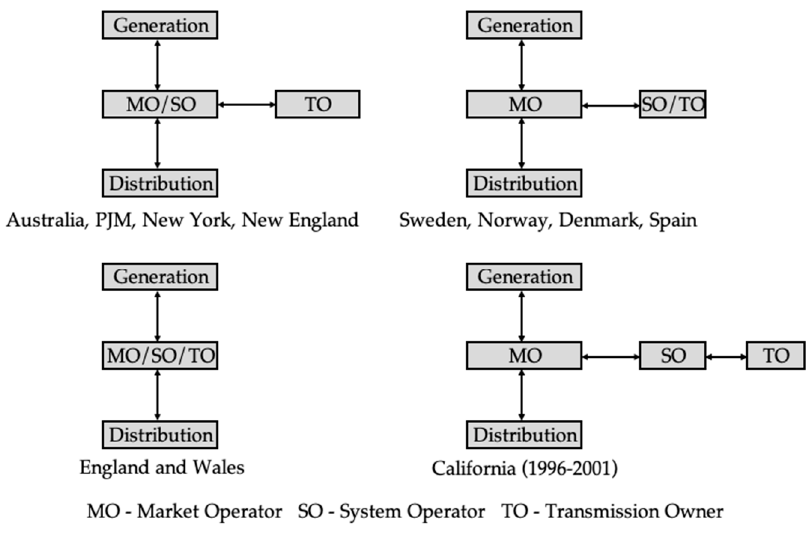
Figure 3. Deregulated market models around the world [21].